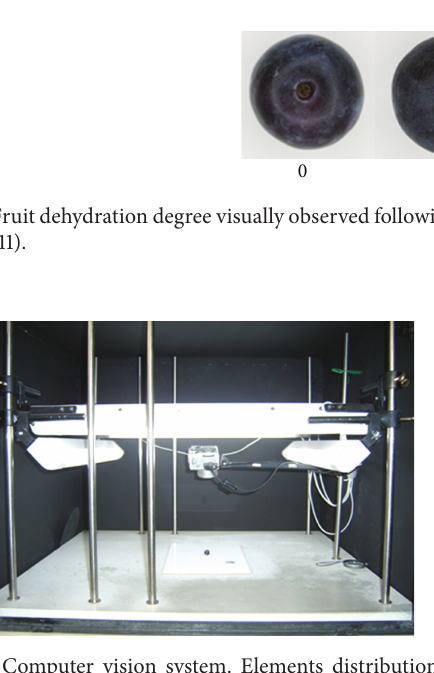
Figure 2: Computer vision system. Elements distribution in the digital image